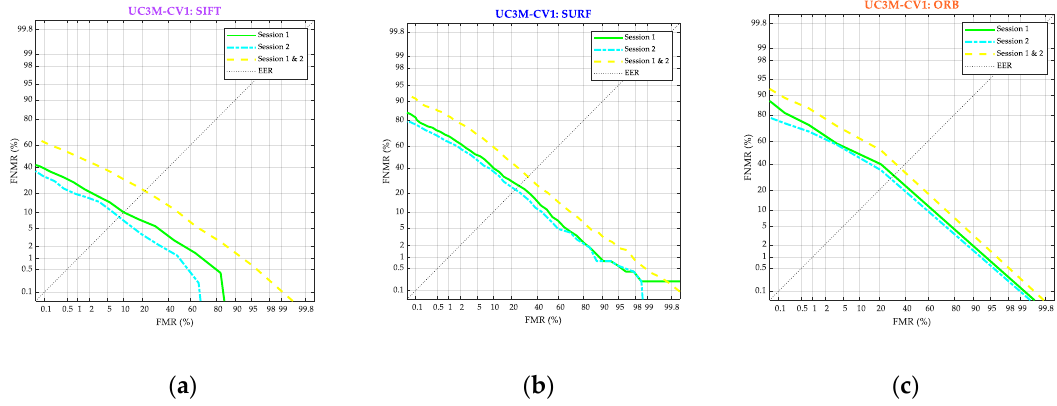
Figure 13. Results: Biometric system performance. Detection Error Trade-Off curve. The False Non-Match Rate is represented versus the False Match Rate. The green (continuous), cyan (line-dot), and yellow (line-line) curves are respectively for Session 1, Session 2, and the full database. ( a ) SIFT ® . ( b ) SURF ® . ( c ) ORB.